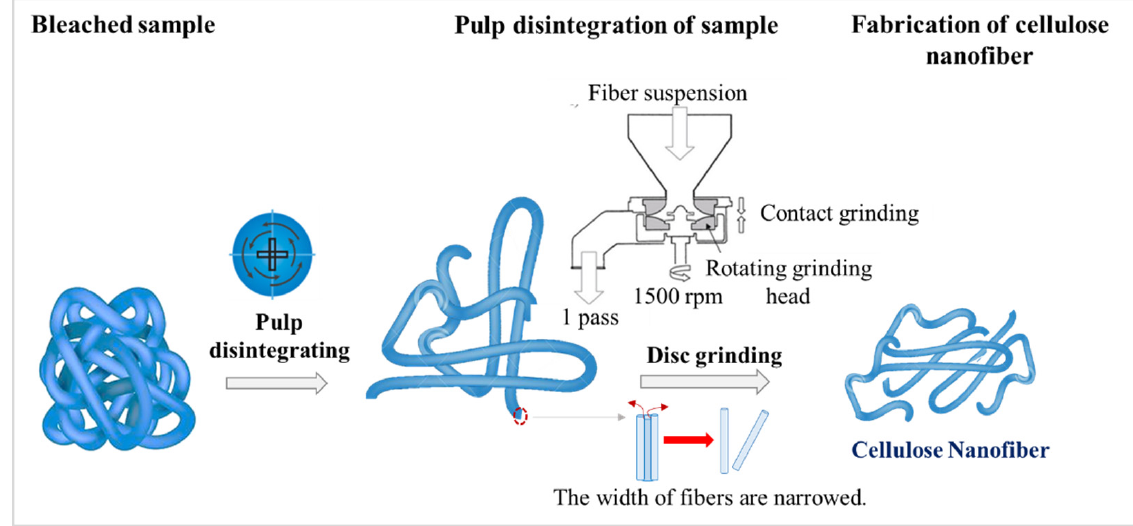
Figure 11. Mechanism of fabricating CNFs using a disc grinder (method A).